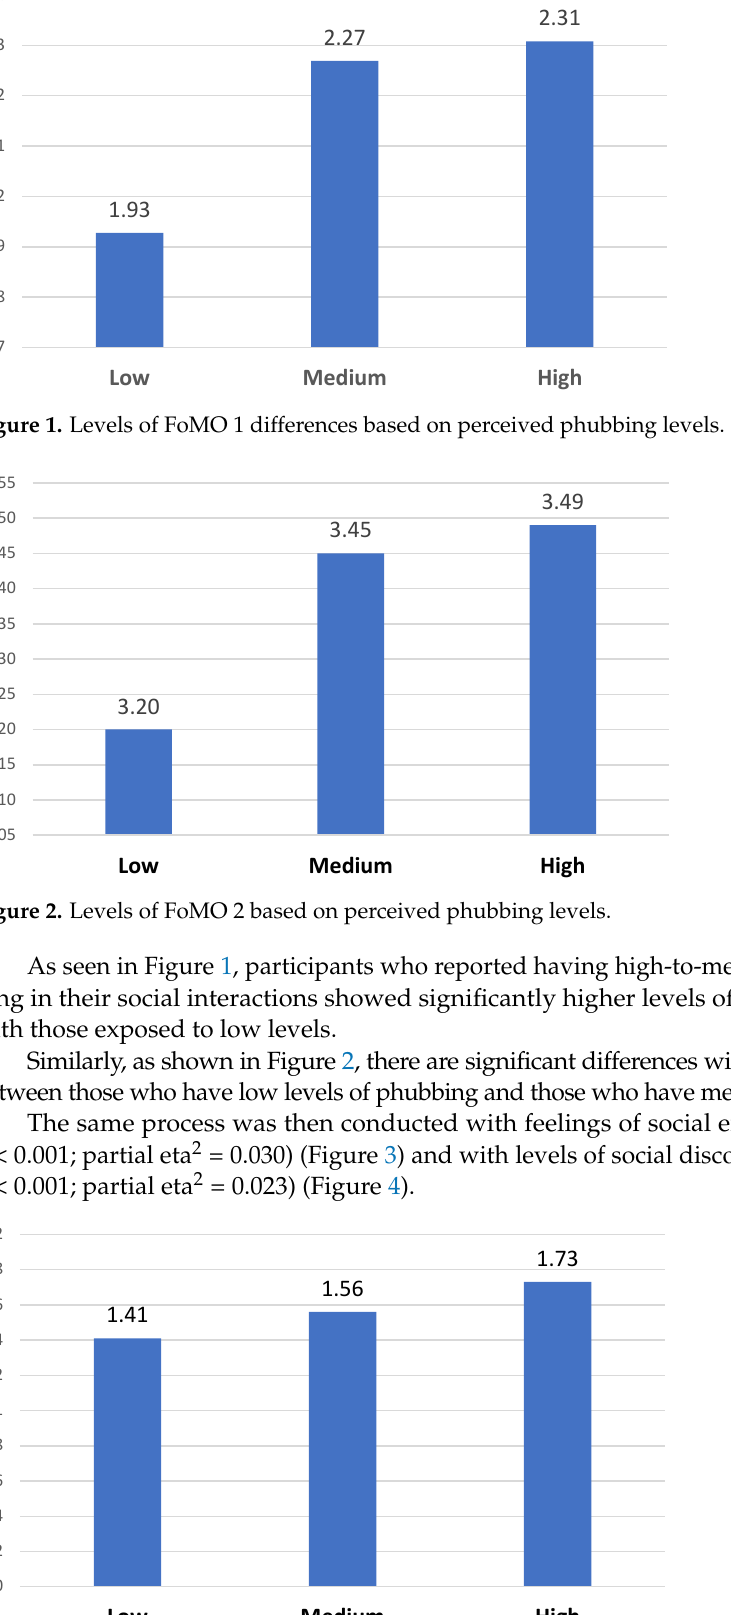
Figure 4. Social disconnection differences based on perceived phubbing levels. As seen in Figure 3, regarding feelings of social exclusion (Figure 3), significant differ ‐ ences were observed in the three groups, corresponding to the low, medium, and high levels. In contrast with the results for FoMO, in the results for feelings of social exclusion, the differ ‐ ences between the three evaluated levels of perceived phubbing are relevant for this analysis (and not only the comparison between high–medium levels with respect to low levels).